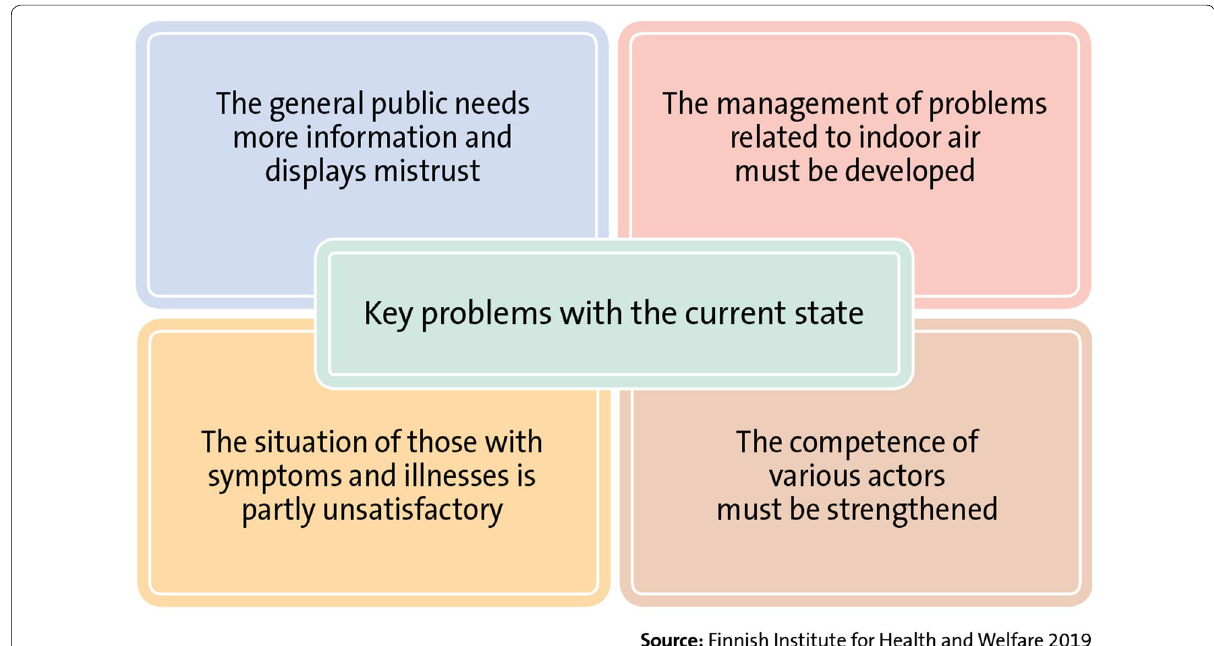
Fig. 3 Key problems with the current state and the aspects on which the Finnish Indoor Air and Health Programme will focus. The situation also requires measures on enhancement of processes related to construction, use, and maintenance of